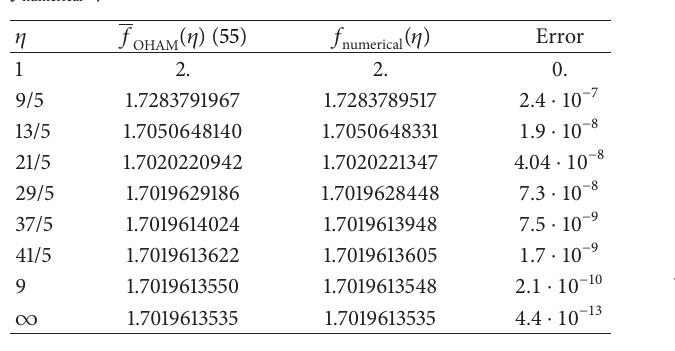
Figure 2: Displacement for different values of 𝑆 when 𝛾 = 1 . (𝜂) − OHAM